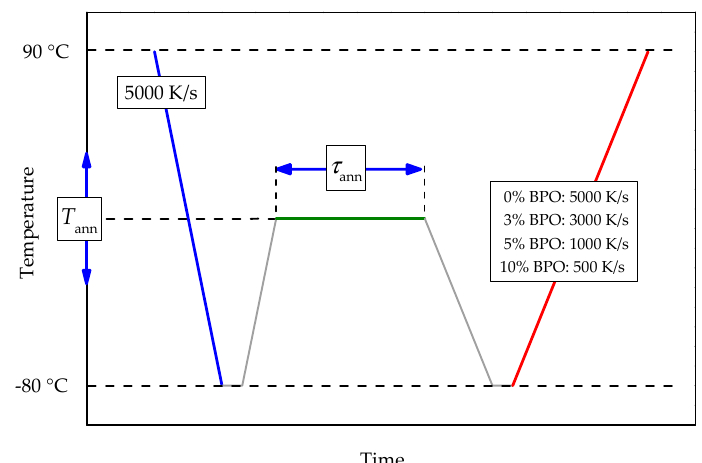
Figure 1. Scheme of the temperature program for the investigation of crystal nucleation and crystallization kinetics of cross-linked PCL. Cooling and heating rates for all steps except the analysis scan are 5000 K/s. The heating rate of the analysis scan depends on the cross-link density of the sample; red line, see the legend. Annealing temperatures ( T ann ) are between − 65 °C and 20 °C with a 5 °C increment. Annealing times ( τ ann ) are between 0.01 and 5000 s evenly spaced on a logarithmic scale.